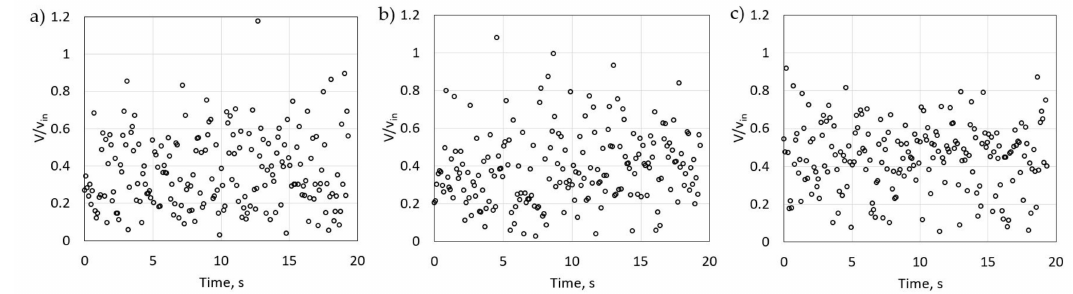
Figure 19. Variations in velocity for point F in time for ( a ) Q = 5 m 3 / h, ( b ) Q = 7.5 m 3 / h, and ( c ) Q = 10 m 3 /